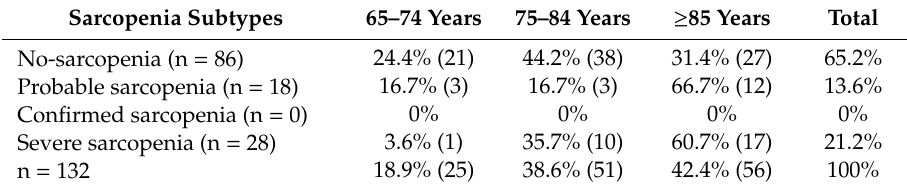
Table 5. Age-stratified sarcopenia prevalence: percentages and (n).